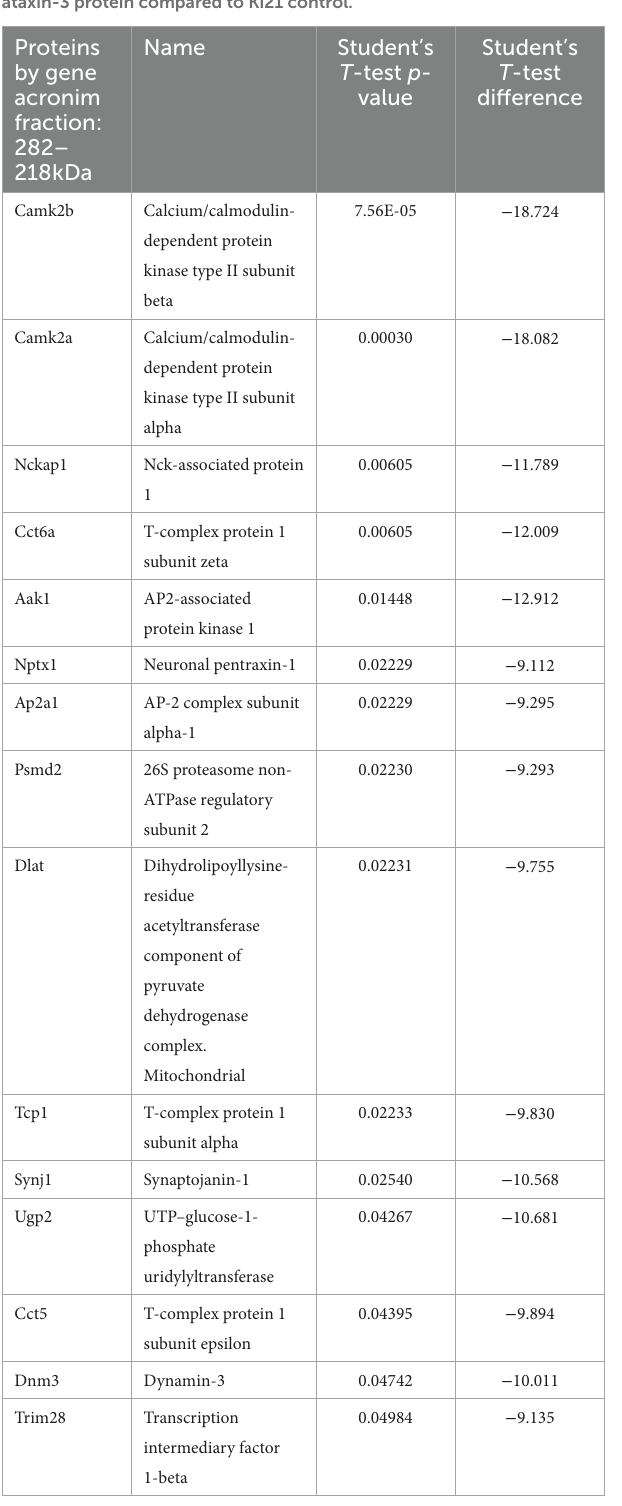
TABLE 1 Proteins depleted in Ki150 fractions 282–218 kDa positive for ataxin-3 protein compared to Ki21 control.